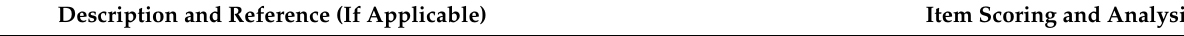
Table 1. Measures evaluated in this